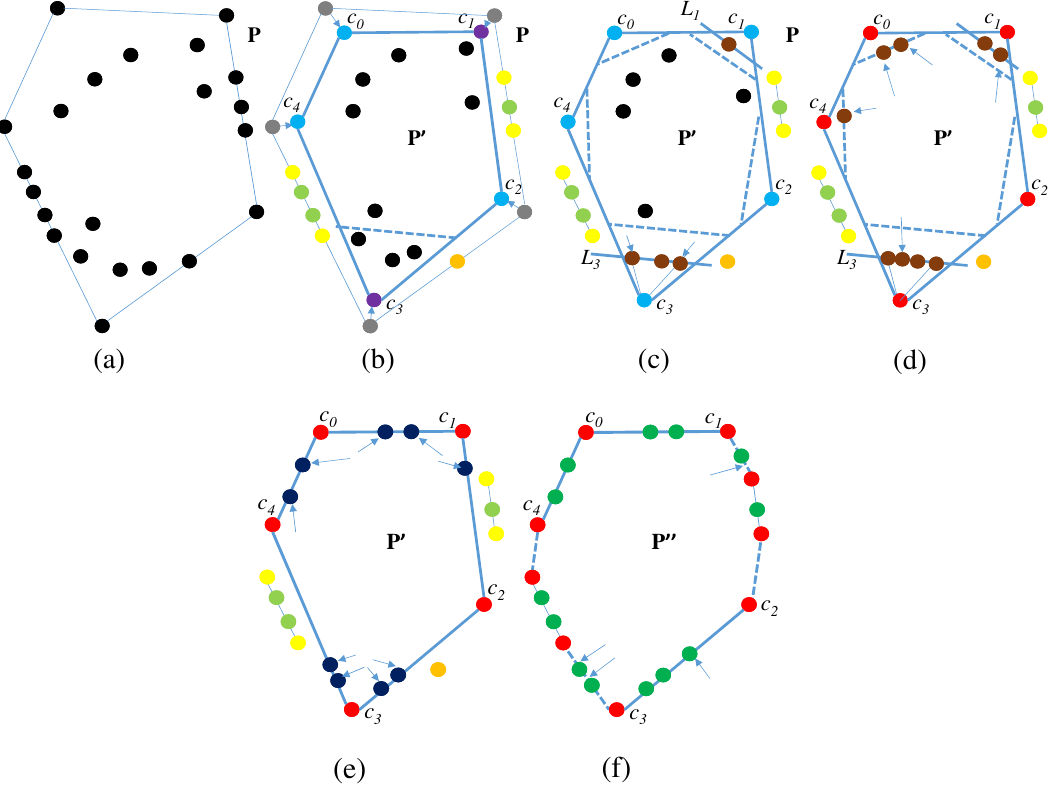
Figure 9. The five sub-stages, Stages 1.1–1.5, of Stage 1: ( a ) starting configuration for Stage 1, and ( b – f ) after Stages 1.1–1.5,